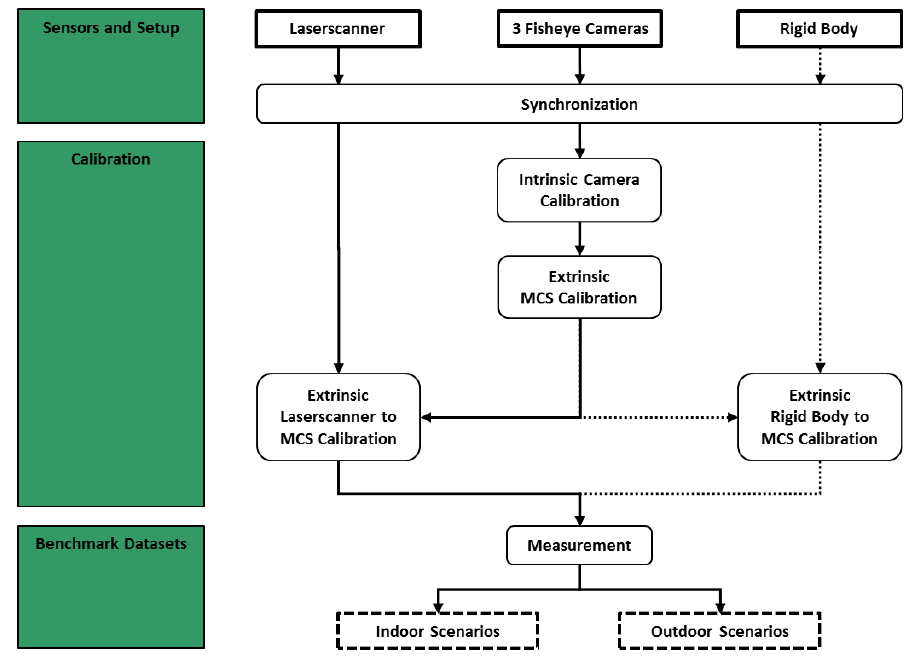
Figure 2. Workflow of the Laserscanner Multi-Fisheye Camera Dataset (LaFiDa). MCS: multi-fisheye camera system Table 2. Specifications of the